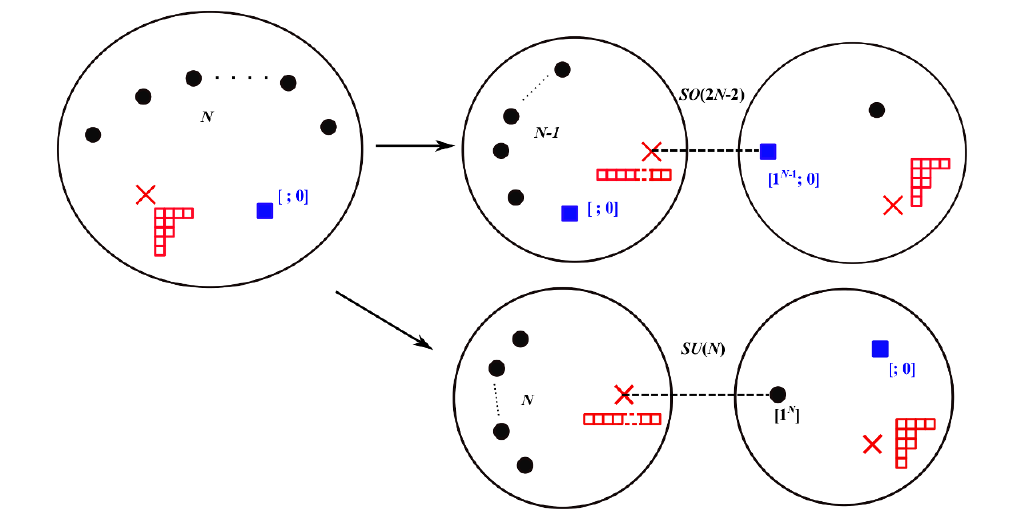
Figure 8 . The weakly coupled duality frame for D N theory of class ( k; 1). One starts with maximal irregular puncture and a regular puncture, and recursively degenerate a sequence of Argyres-Douglas matter. The (cid:12)rst line gives Argyres-Douglas matter